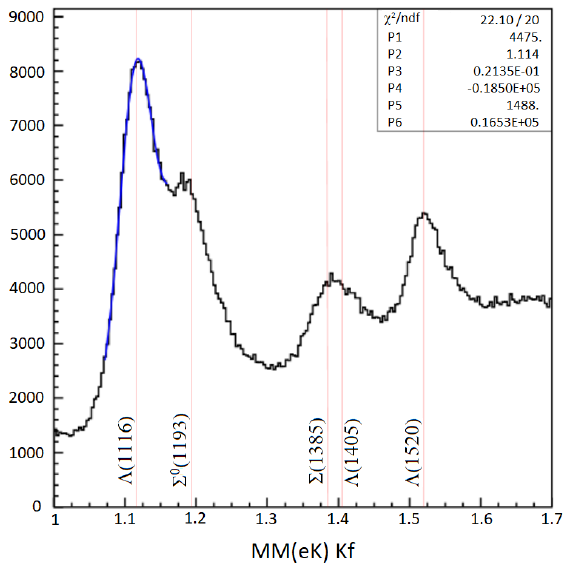
Figure 5. MM( e − K + )(GeV) plot using data from 15 Runs ac- quired during Fall 2018 requiring a K + detected in the Forward Detector. The vertical lines on the plot represent the nominal masses of the Λ and Σ hyperons. The blue line is the fit on the Λ 0 peak and the parameters are in the top right box. Λ 0 (1116) and Σ 0 (1193) baryons peaks can be distinguished. Courtesy of D.